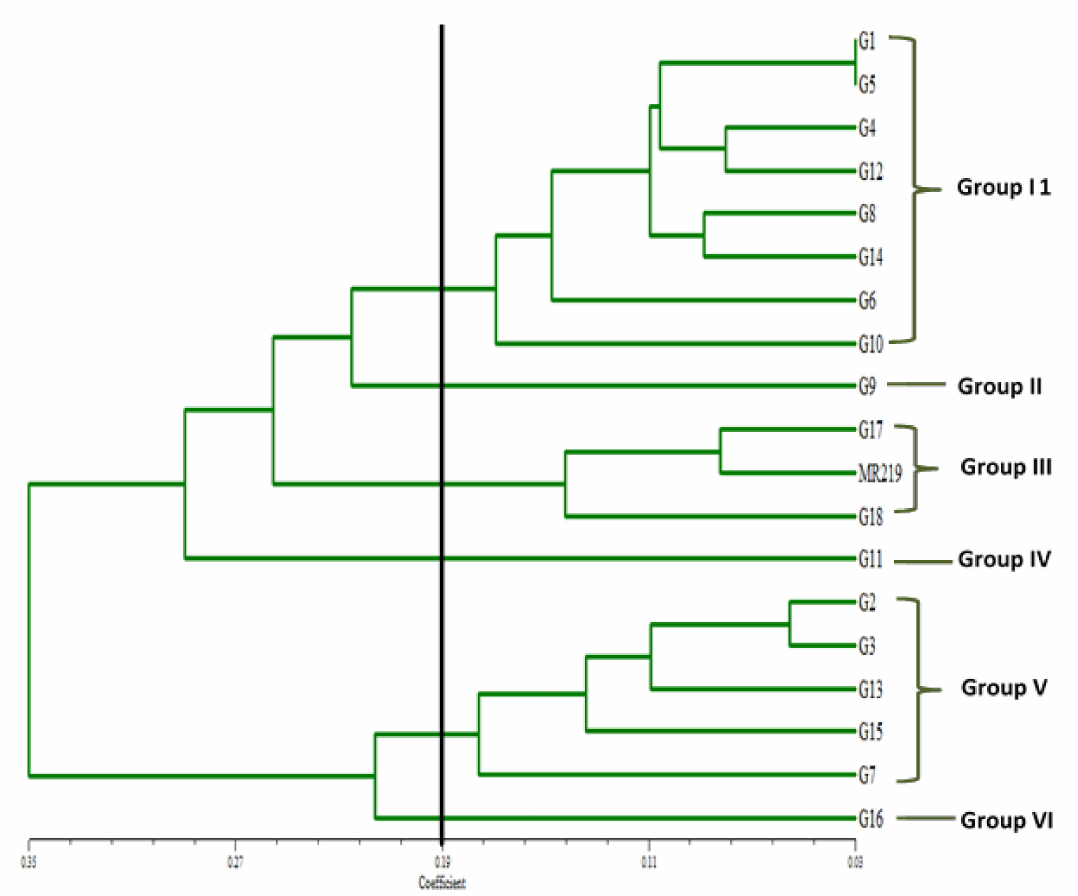
Figure 1. Clustering pattern of 19 rice genotypes evaluated in four di ff erent